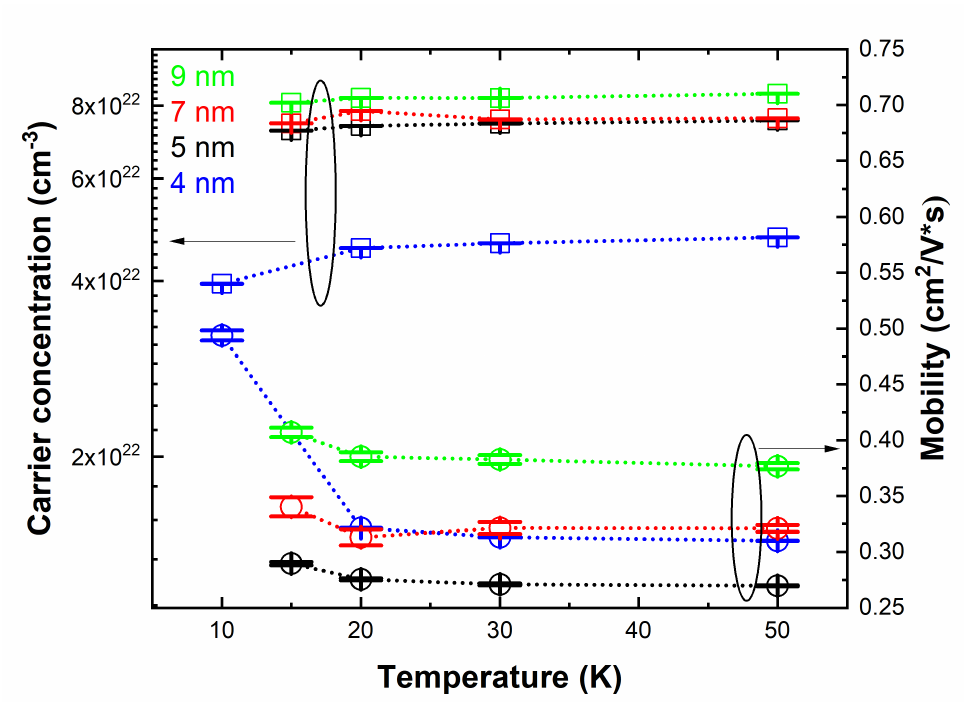
Figure 3. ( Left axis ) Temperature-dependent carrier concentration in cm − 3 and ( right axis ) mobility in cm 2 /Vs of a 9, 7, 5, and 4 nm-thick NbN thin film on sapphire above the critical temperature. The carrier concentration and mobility of bulk NbN is also indicated. The measurement error is indicated by error bars and lies in the range 3.24 × 10 17 cm − 3 to 1.97 × 10 19 cm − 3 for carrier concentration and in the range 0.8 × 10 − 4 cm 2 /Vs to 86 × 10 − 4 cm 2 /Vs for